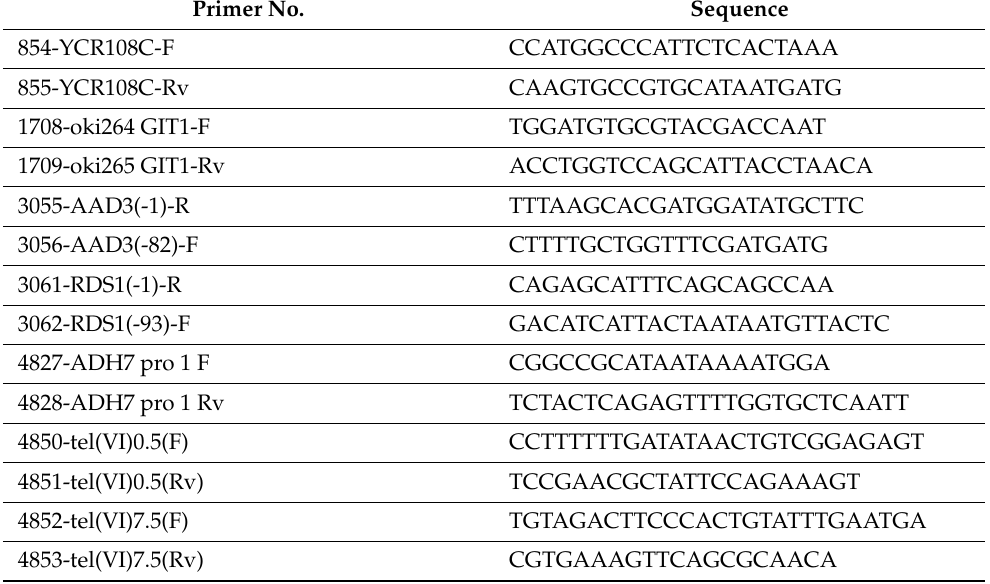
Table 3. Primer list for ChIP.